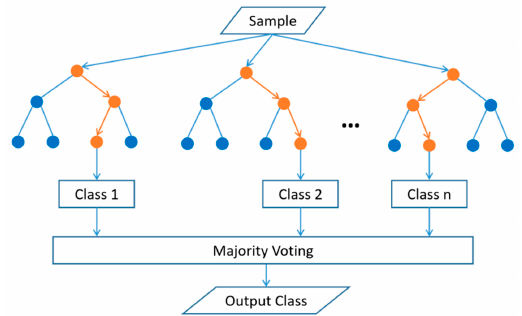
Figure 6. Illustration of Random Forest classi fi er.